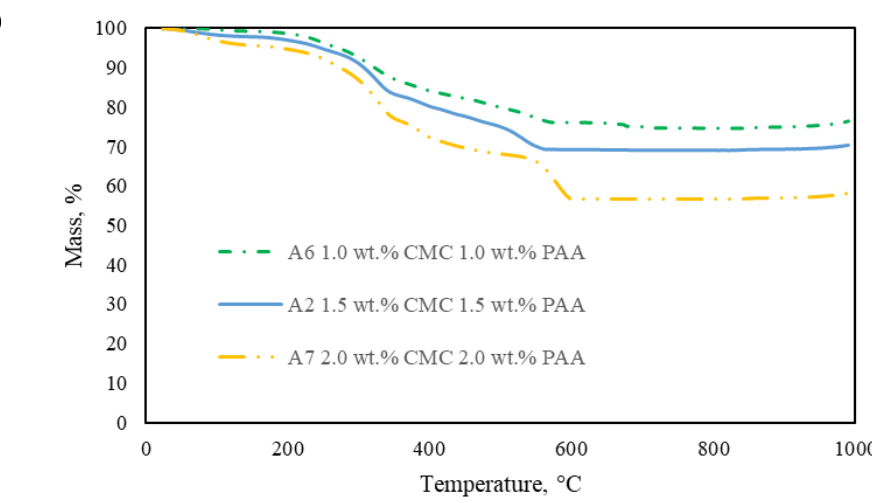
Figure 7. Thermal conductivity of the AAs compared to other thermal insulators ( a ). TGA curves of the AAs with varying Al contents at 1.5 wt.% CMC and 1.5 wt.% PAA ( b ). DTA curves of the AAs ( c ). TGA curves of AAs with varying crosslinker concentration at 6.0 wt.% Al ( d ).